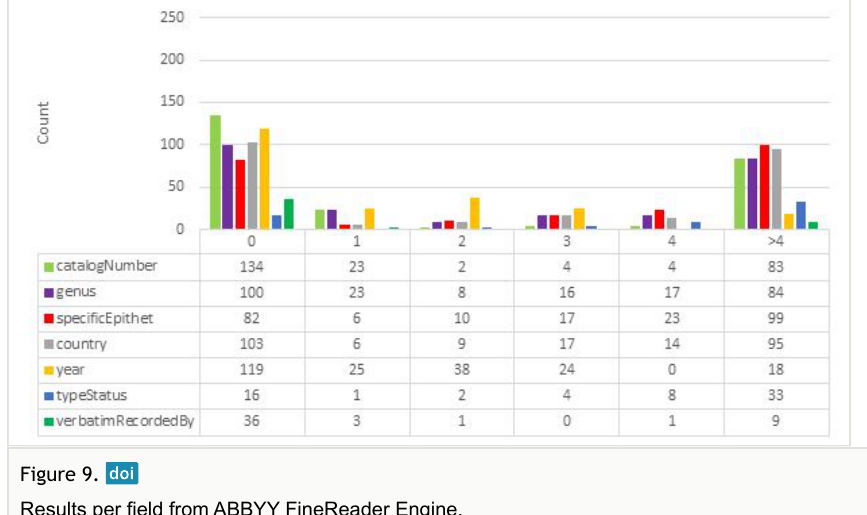
Results per field from ABBYY FineReader Engine.